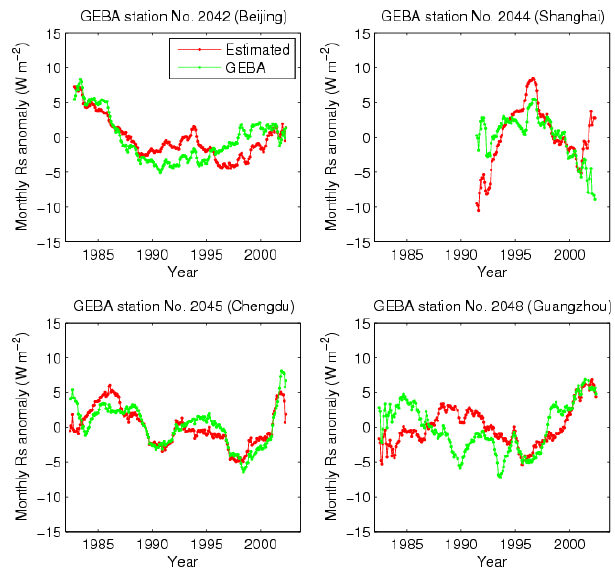
Fig. 8. Comparison between monthly SunDu derived and direct observed R s at four baseline stations in China.